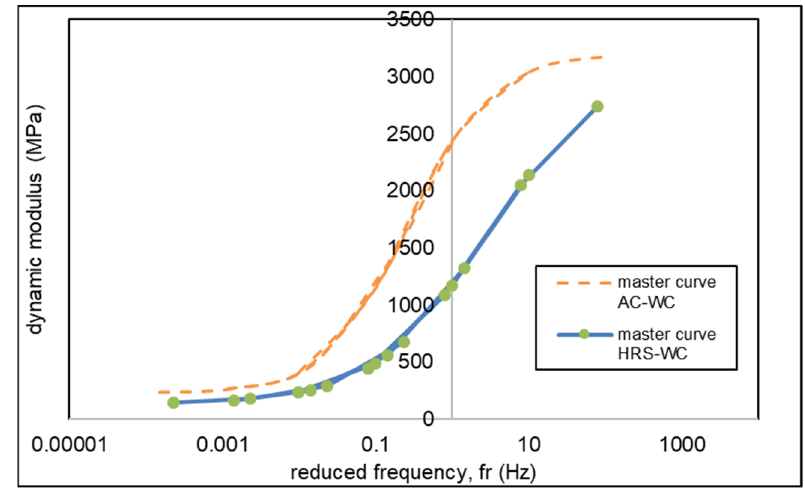
Figure 12. Comparison of master curves for AC-WC and HRS-WC mixtures.